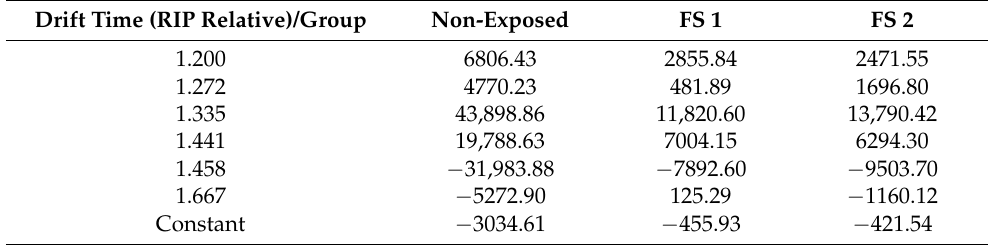
Table 1. Fisher’s linear discriminant functions obtained from LDA at different drift times. Drift Time (RIP Relative)/Group Non-Exposed Constant −